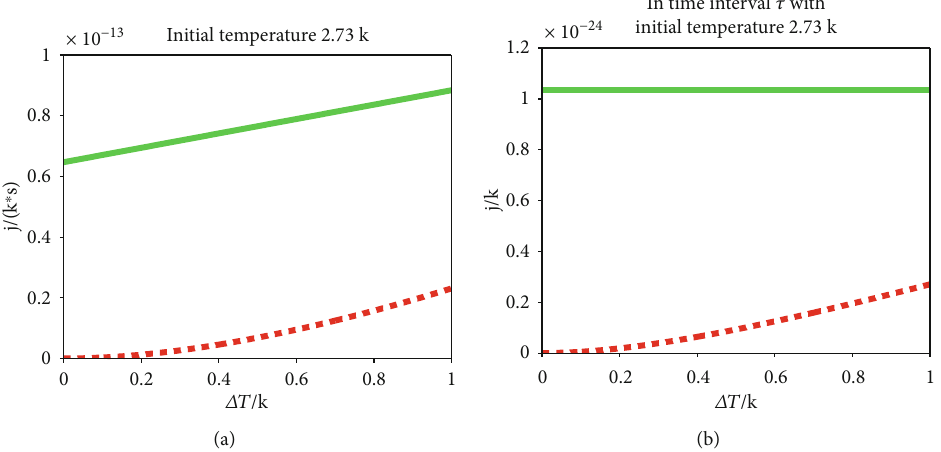
Δ M , Δ S e / Δ S varying with the temperature di ff erence with an initial temperature 2.73k, respectively. H / BH BH